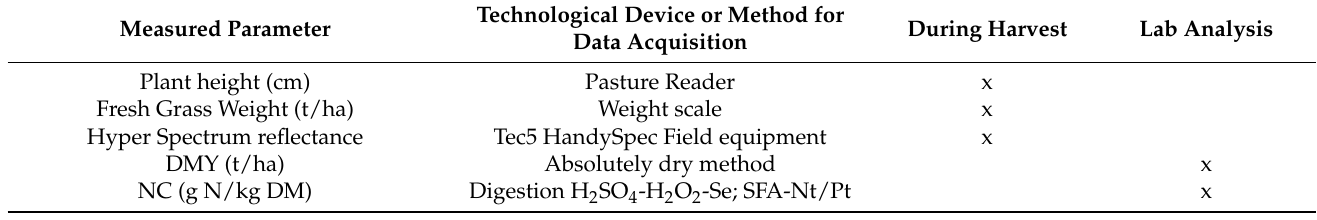
Figure 2. Sensors used to measure grass in the field experiment. Table 1. Measured Parameters of Grass.